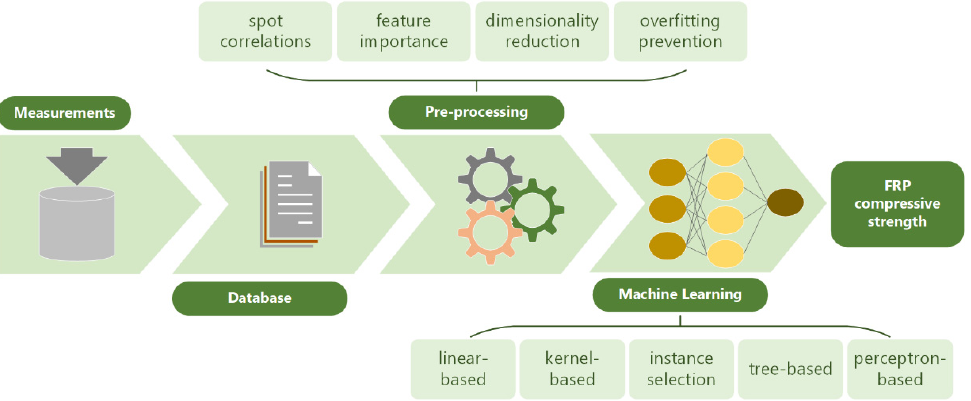
Figure 1. ML approach to predict concrete compressive strength from experimental data.